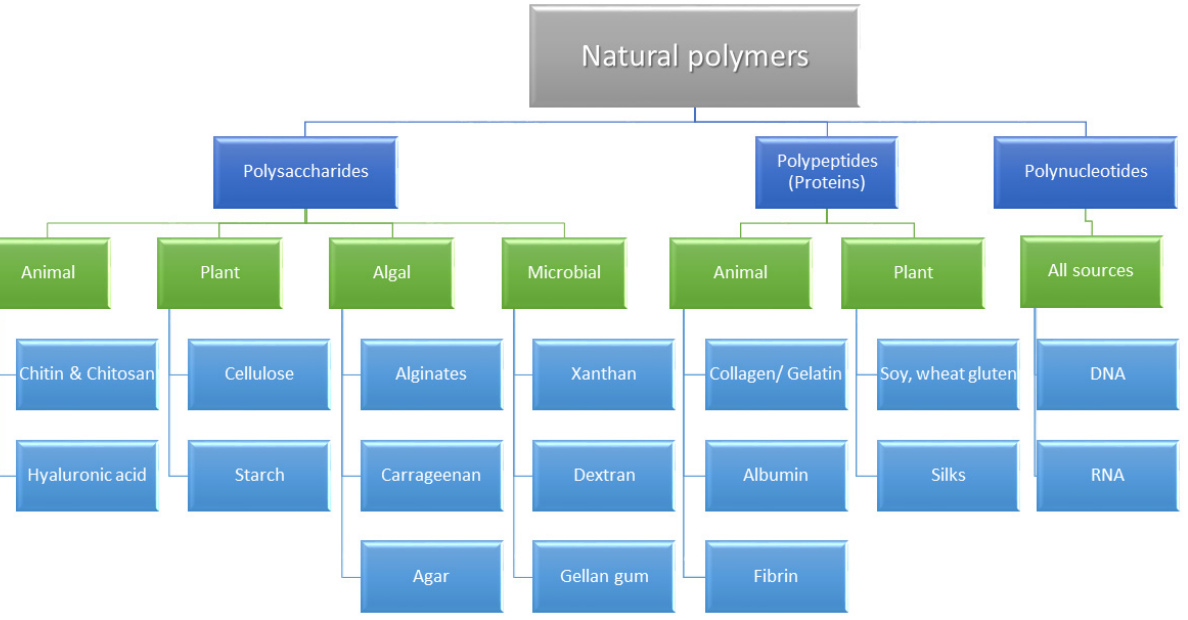
Figure 2. Classification of natural polymers based on their chemical structure and their source of origin [14].